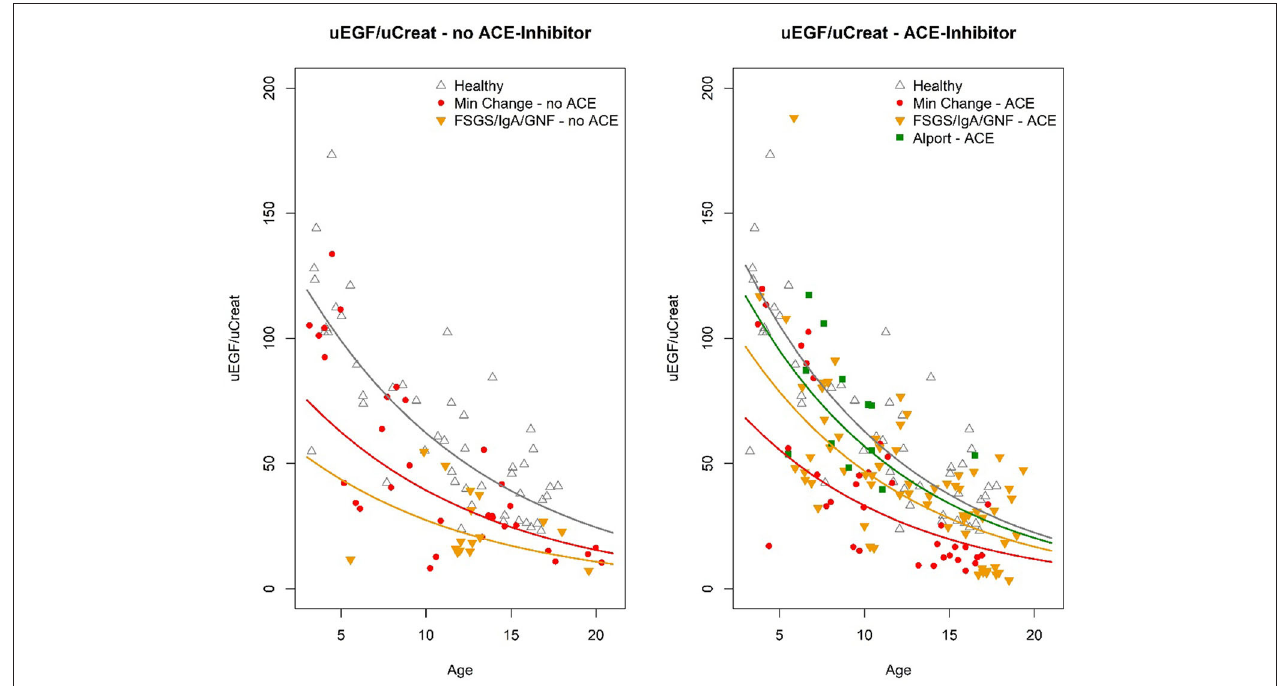
FIGURE 2 | Graphical compilation visualizing the absolute values of U EGF/uCreat for age, according to the different clusters of biopsy results, comparing patients treated with ACE inhibitor to those without ACE inhibition.